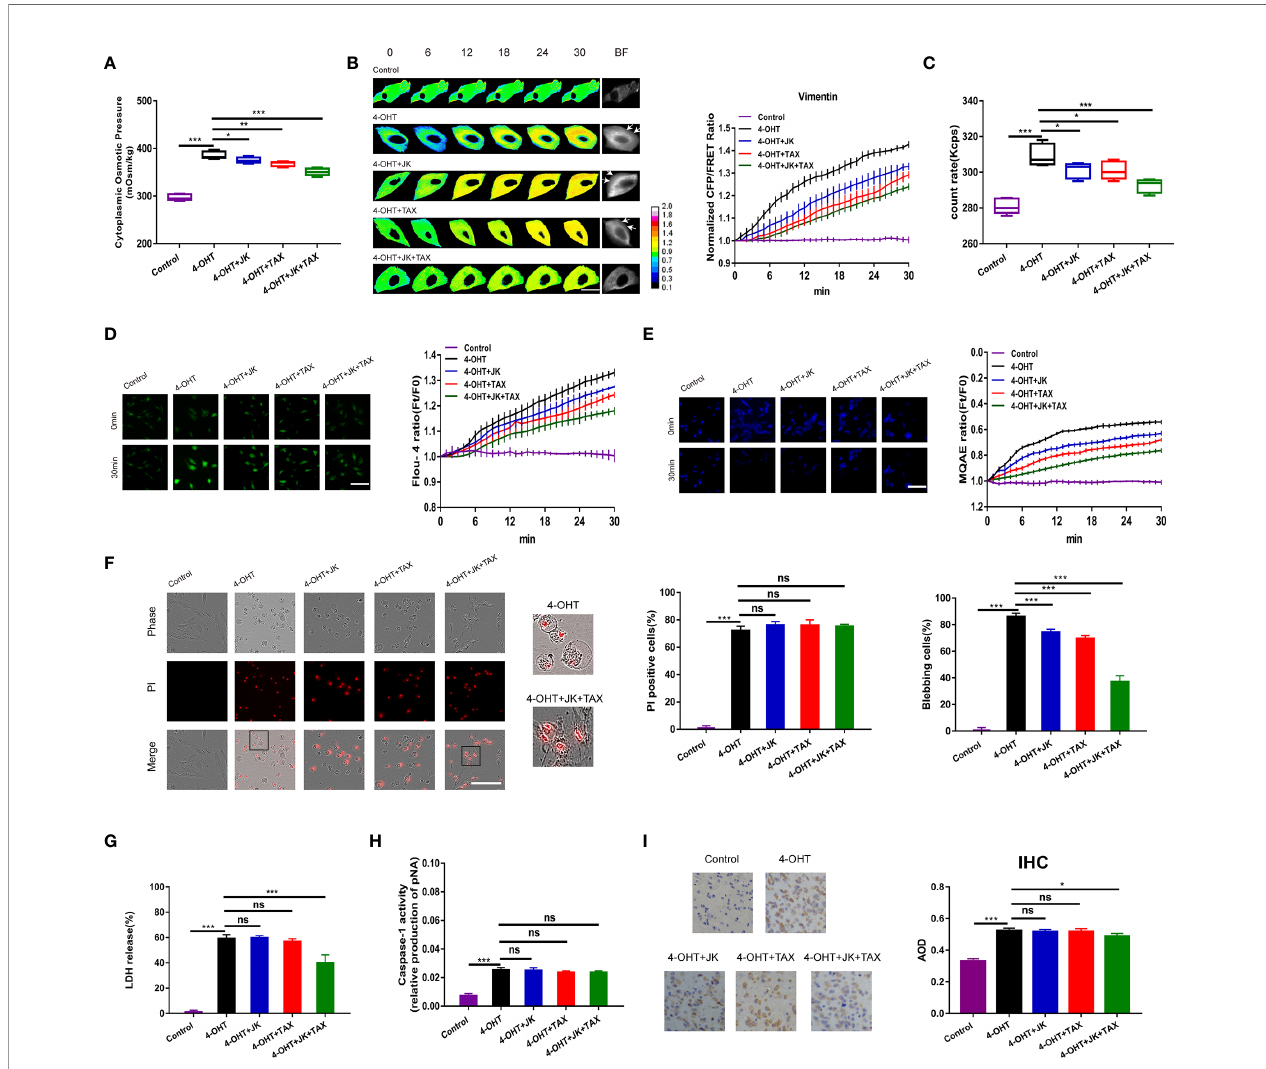
FIGURE 1 | MF and MT stabilization antagonized cell swelling but did not alter membrane permeability. (A) The cytoplasmic OP values of U87 cells were measured using a freezing point osmometer under 4-OHT treatment (5 m g/ml), co-treatment of 4-OHT with jasplakinolide (JK, 10 m M), taxol (TAX, 10 m M), both agents, and the isotonic control. (B) Representative images and mean values of normalized CFP/FRET ratios of Vimentin tension under the different treatments. Arrows indicate the membrane blebbing regions. The calibration bar was set from 0.1 to 2.0. Scale bar, 10 m m. (C) The count rate of PNs in U87 cells. (D) Calcium imaging micrographs and traces of relative Fluo-4 fl uorescence intensity (Ft/F0) of cells. Scale bar, 100 m m. (E) Chloridion imaging micrographs and traces of relative MQAE fl uorescence intensity (Ft/F0) of cells. The increase of intracellular Cl - levels led to the decrease of MQAE fl uorescence value instead. Scale bar, 100 m m. (F) Representative time- lapse images of U87 cells subjected to different treatments. Cell membrane permeabilization was monitored by PI uptake (red fl uorescence). The bar charts represent the percentage of PI positive cells and blebbing cells, respectively. Scale bar, 100 m m. (G) LDH release and (H) caspase-1 activity of cells under the different treatments. (I) IHC analysis of caspase-1 expression in brain section of the sepsis mouse models. The cytoplasm was stained with the caspase-1 antibody (brown). Semiquantitative analysis of the IHC staining by the average optical density (AOD) among the groups. Mean of ≥ 3 experiments ± SEM. Values marked with asterisks are signi fi cantly different, as determined using a t -test. ns, not signi fi